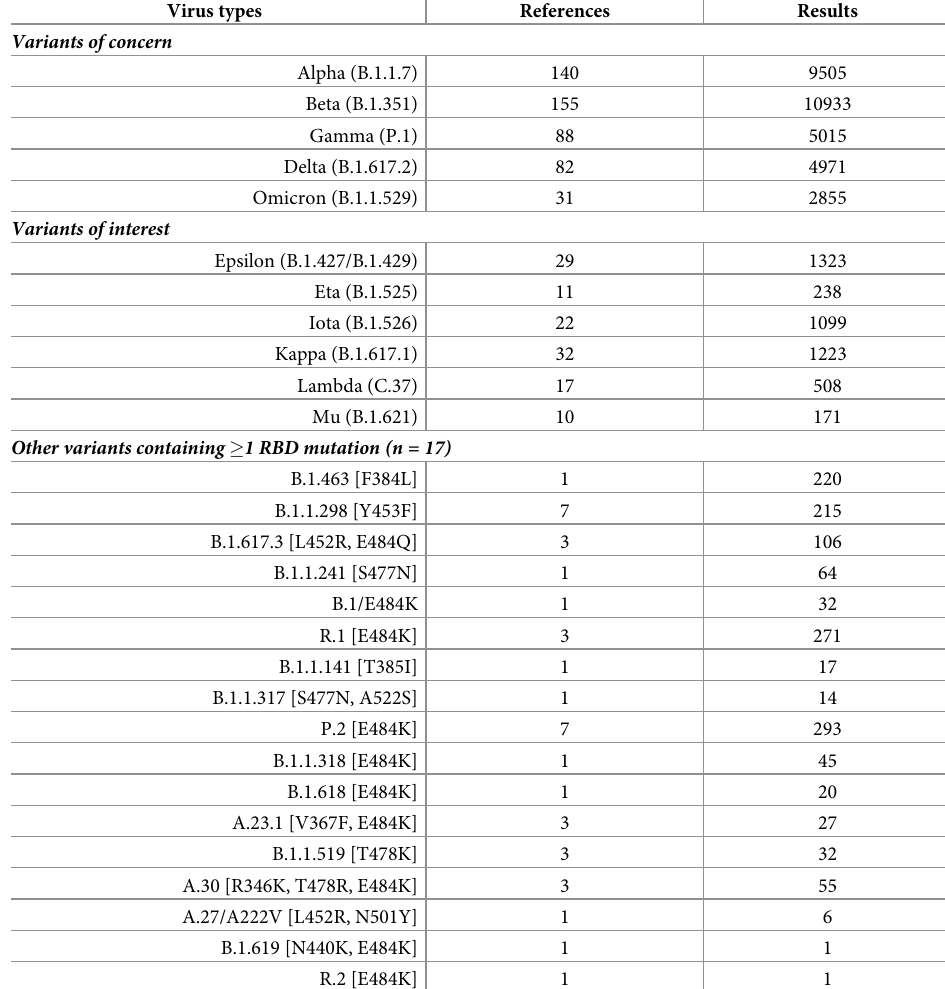
Table 1. Variants of concern, variants of interest, and other variants for which neutralization data are available in